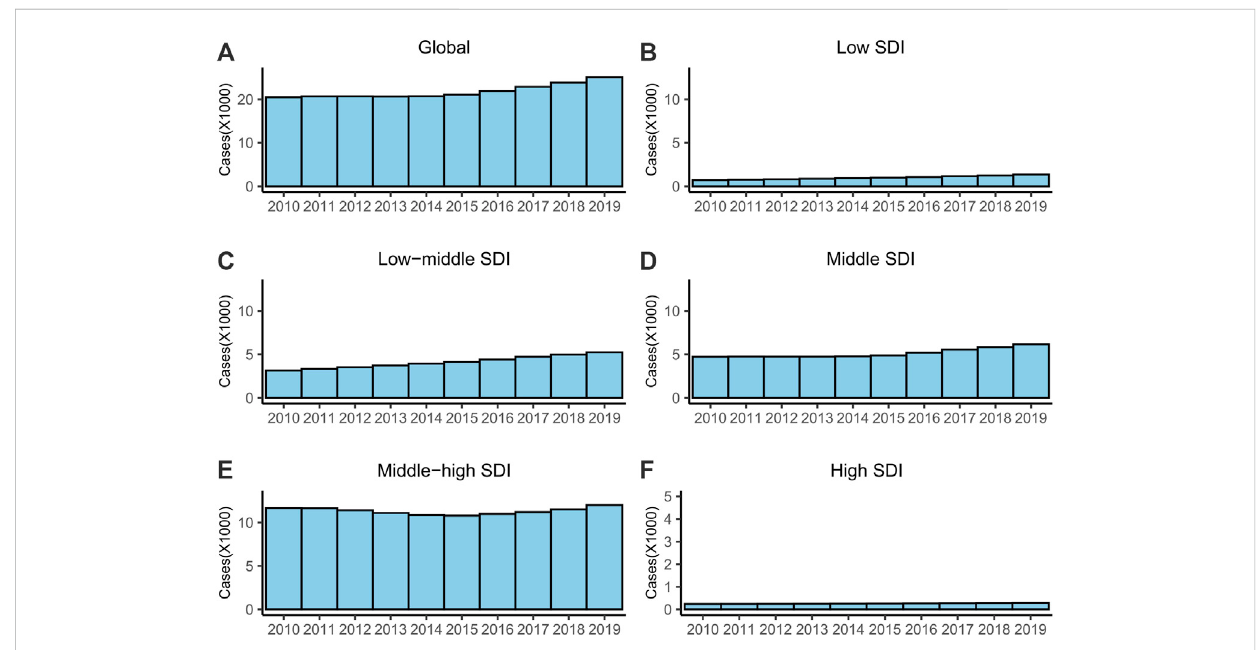
(Table 1). The high SDI regions had the fewest cases, and the lowest ASR and MDR rates (Table 1; Figure 1). The number of MDR-TB cases increased monotonically in the low- and low-middle SDI regions (Figure